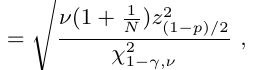
The upper and lower tolerance intervals are marked with red lines in Fig.